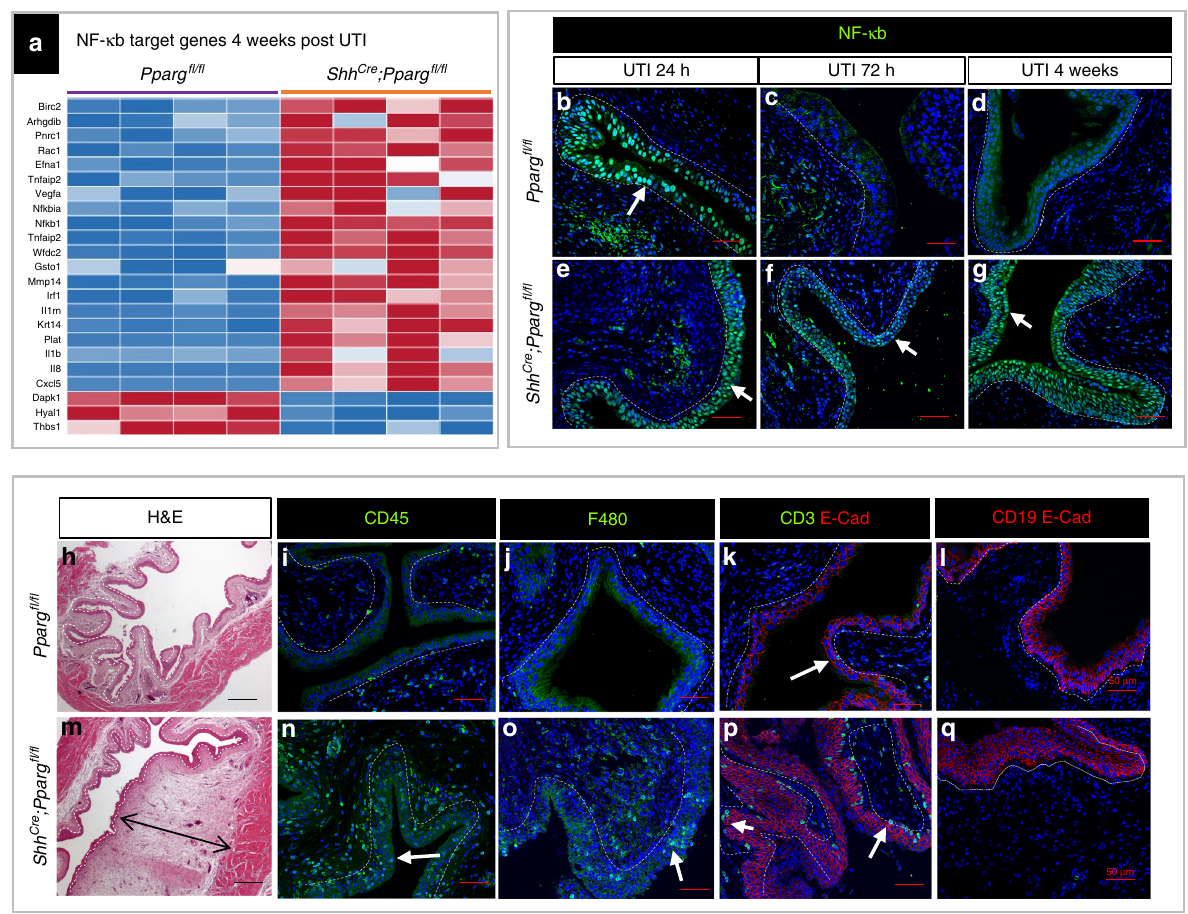
Fig. 10 Pparg is required for proper regulation of NF- κ B. a Heatmap showing changes in NF- κ B target genes in the urothelium of Shh Cre ;Pparg fl / fl mutants compared to Pparg fl / fl controls 4 weeks after UTI. b – d Expression of NF- κ B (Rela), in the urothelium of adult Pparg fl / fl control mice 24 h after UTI ( b ), 72 h after UTI ( c ), and 4 weeks after UTI ( d ). e – g Expression of NF- κ B (Rela) in the urothelium of a Shh Cre ;Pparg fl / fl mutant 24 h post UTI ( e ), 72 h post UTI ( f ), and 4 weeks post infection ( g ). White arrows pointed to urothelial cells with nuclear Rela staining. Analysis of Pparg fl / fl controls ( h – l ) and Shh Cre ;Pparg fl / fl mutants ( m – q ) 4 weeks after UTI. Hematoxylin and eosin staining of the urothelium of an adult Pparg fl / fl control mouse ( h ) and a Shh Cre ;Pparg fl / fl mutant mouse ( m ). CD45 expression in the urothelium of an adult Pparg fl / fl control mouse ( i ) and a Shh Cre ;Pparg fl / fl mutant mouse ( n ). F480 expression in the urothelium of an adult Pparg fl / fl control mouse ( j ) and a Shh Cre ;Pparg fl / fl mutant mouse ( o ). CD3/Ecad expression in the urothelium of an adult Pparg fl / fl control mouse ( k ) and a Shh Cre ;Pparg fl / fl mutant mouse ( p ). CD19/Ecad expression in the urothelium of a Pparg fl / fl control mouse ( l ) and a Shh Cre ;Pparg fl / fl mutant mouse ( q ). The black arrow in ( m ) denotes edema in the bladder of Shh Cre ;Pparg fl / fl mutants. White arrows in ( b , e , f , g ) point to cells expressing leukocyte markers. Scale bars: 50 μ m. Numbers of animals for experiments: n = 3 Shh Cre ;Pparg fl / fl mutants and three controls were analyzed at 24 h post infection, n = 4 Shh Cre ;Pparg fl / fl mutants and n = 4 controls were analyzed at 72 h post infection, n = 8 controls and n = 11 Shh Cre ;Pparg fl / fl mutants were analyzed at 4 weeks post infection. For RNA-Seq experiments, n = 5 Shh Cre ;Pparg fl / fl mutants and n = 5 controls were